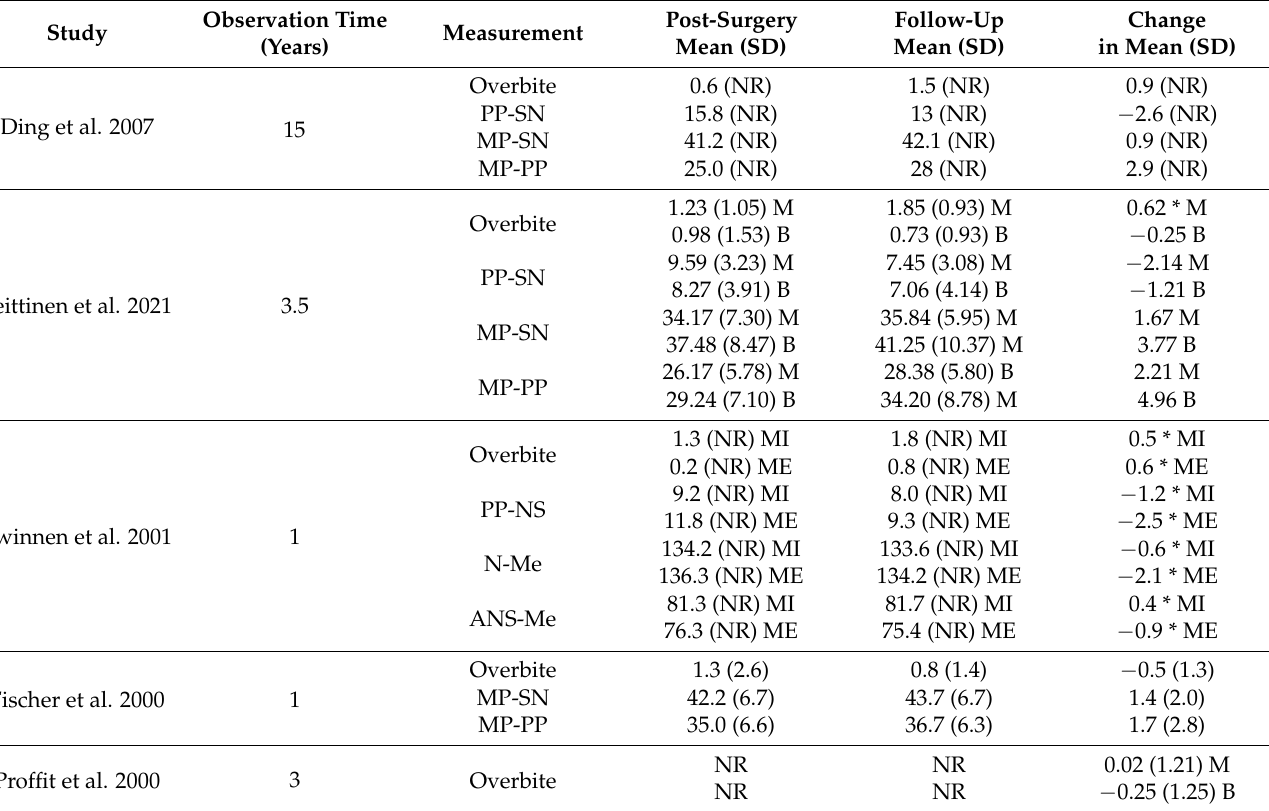
Table 15. Changes in selected values characterizing stability of results of AOB treatment by orthognathic surgery procedures. Observation Time Study